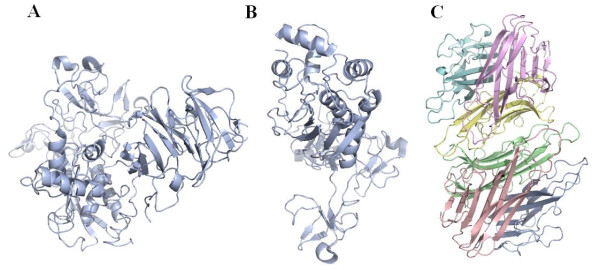
Identification of novel molecular targets using network analysis. A: MMP2; B: MMP9; C: TNF.